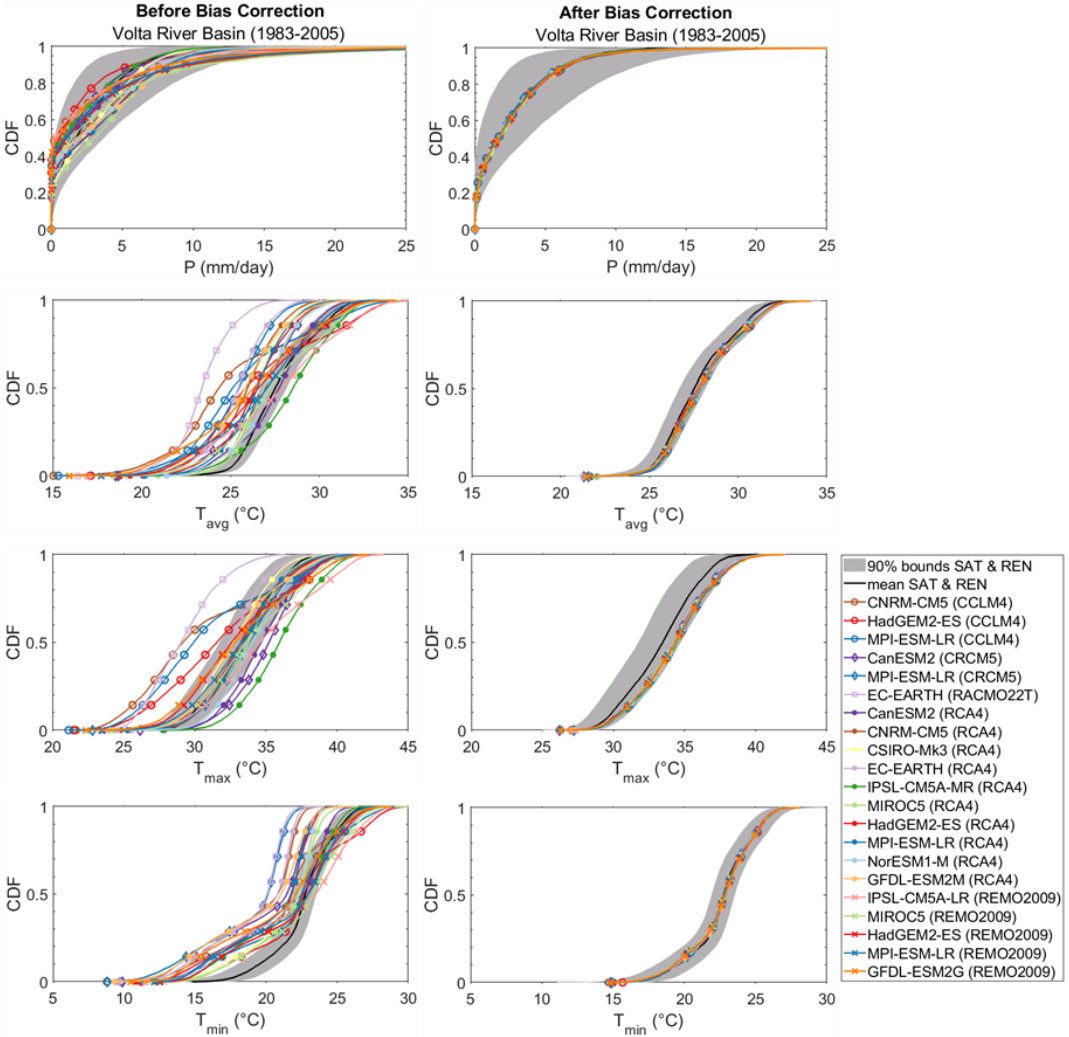
Figure 3. Cumulative distribution functions (CDFs) of daily rainfall ( P ) and average, maximum, and minimum daily air temperature ( T avg , T max , and T min ) before and after multivariate bias correction of various RCM–GCM datasets over the 1983–2005 historical period. The black line and grey shaded area represent the mean and the 90% confidence interval of the satellite and reanalysis datasets of rainfall (10 datasets) and temperature (six